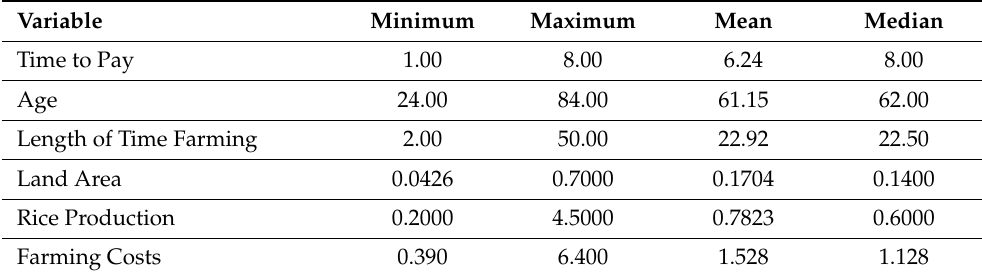
Table 7. Descriptive statistics of numerical